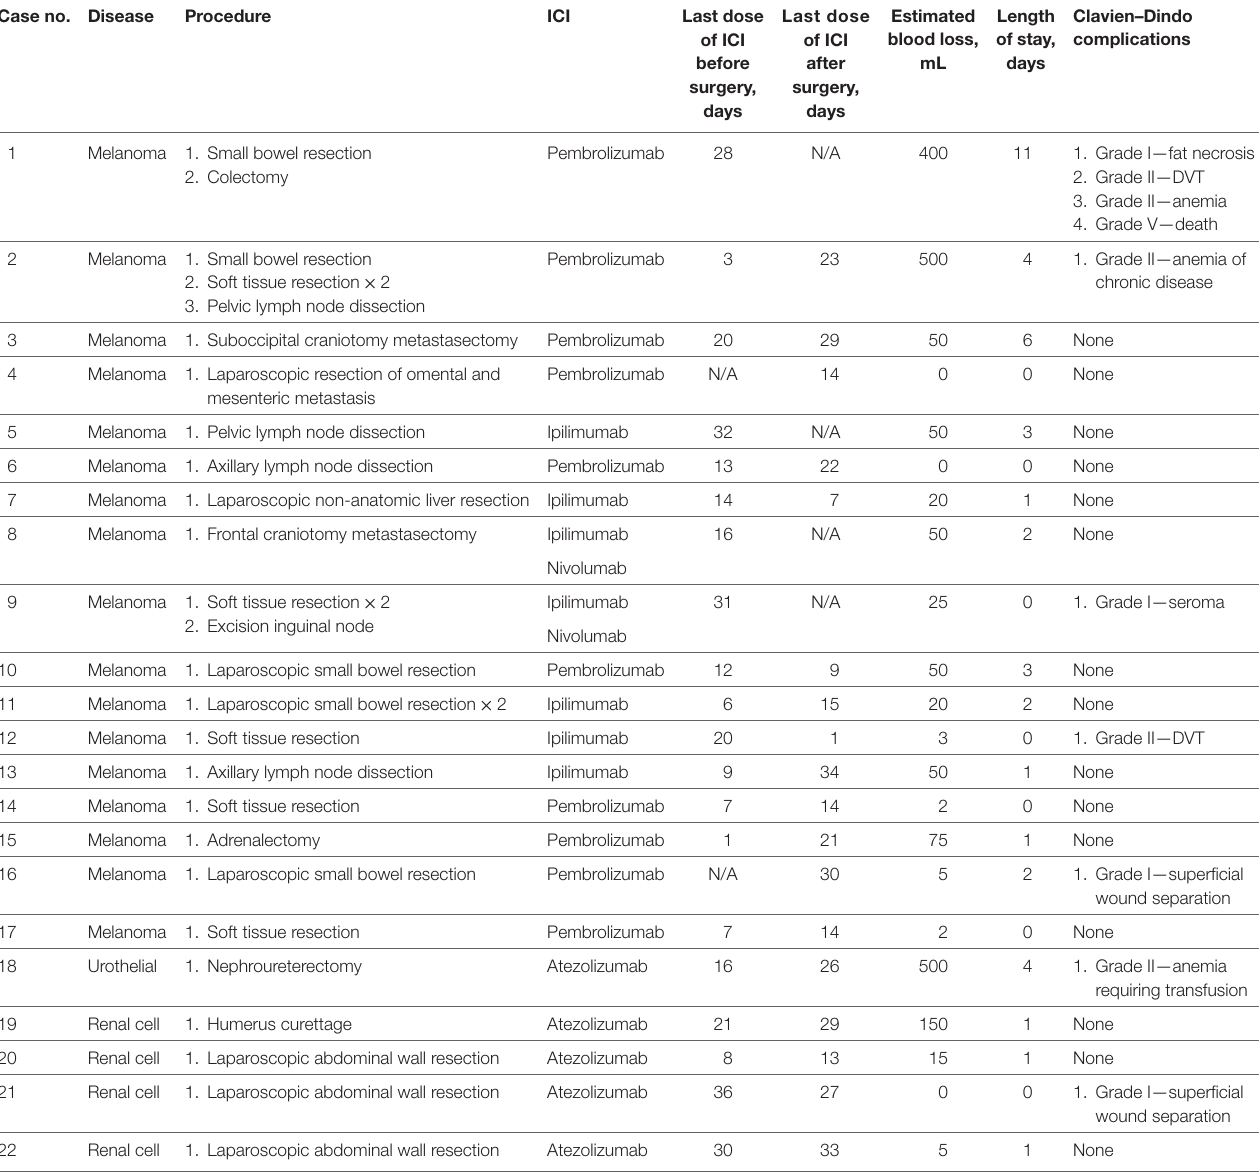
TaBle 2 | Patient characteristics, procedures, and immune checkpoint inhibitors (ICI) therapy. case no.